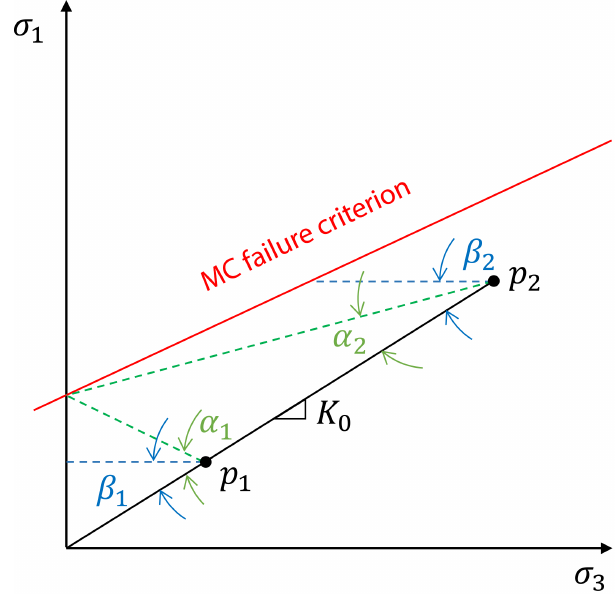
Figure 16. Definition of parameters α and β and estimation of β α < 1, ratios for different stress states. Point 1 (p1) has a ratio β α > 1. Red line: Mohr–Coulomb fail- whereas Point 2 has a ratio of β α ure criterion, blue dashed lines: stress-path during faulting, green dashed lines: connects beginning of the stress-path during faulting (i.e. p1 or p2) with the intersection of the failure criterion and the σ 1